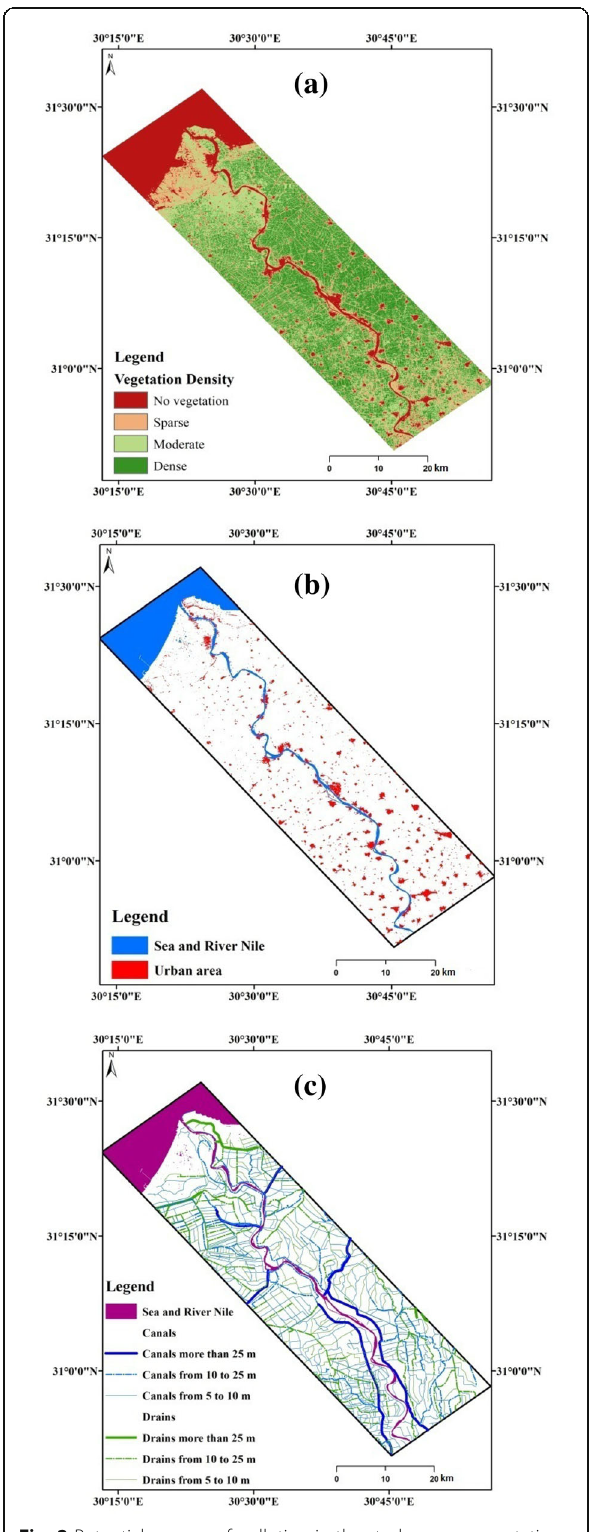
Fig. 2 Potential sources of pollution in the study area; a vegetation, b urban area, c drainage